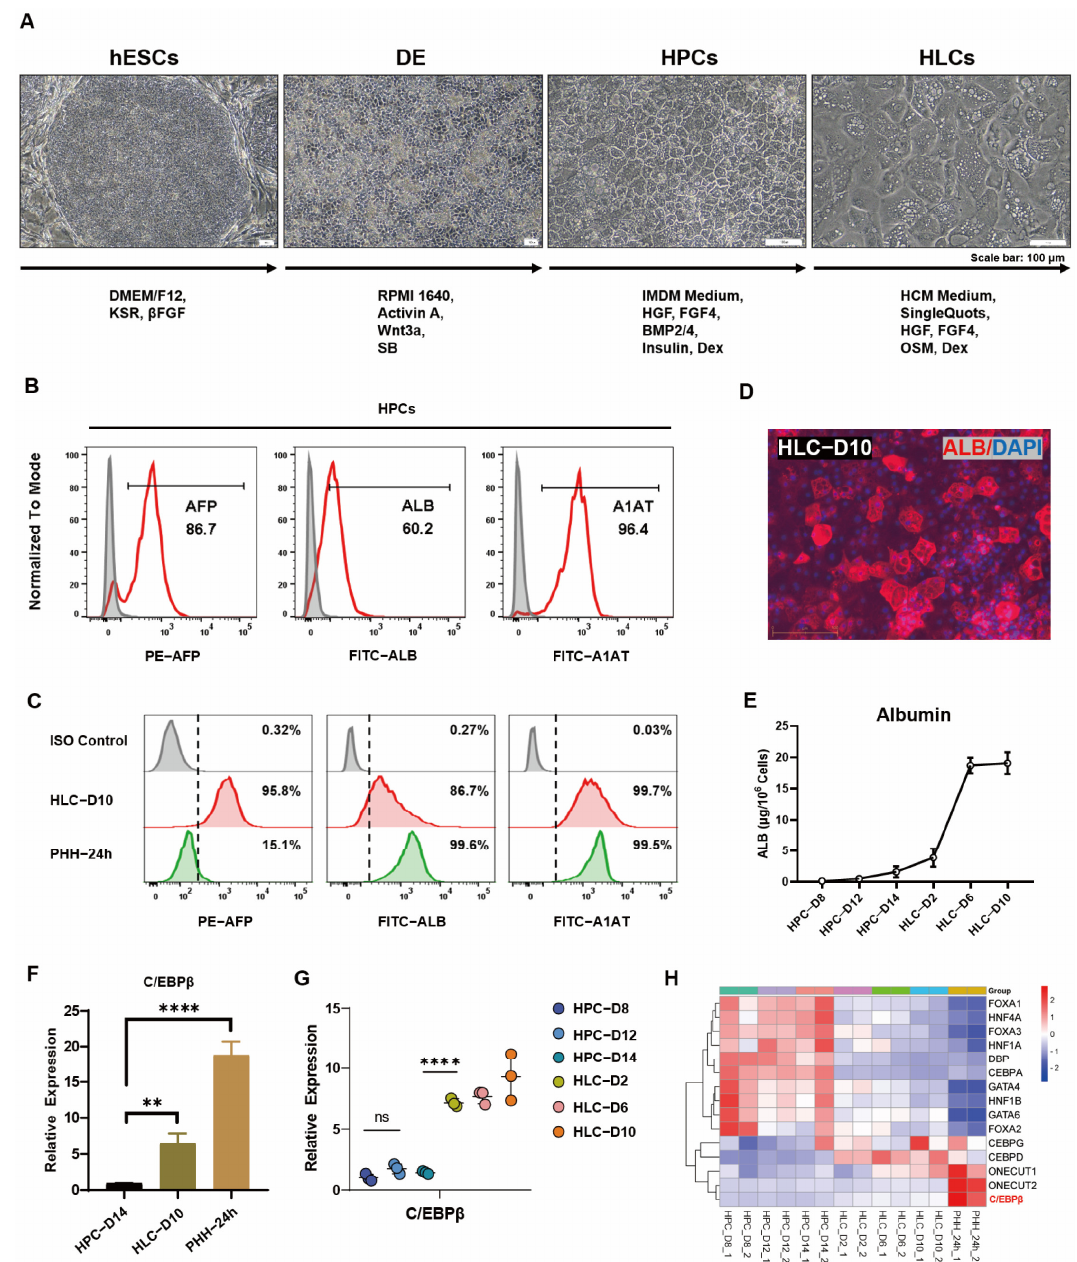
Figure 1. C/EBPβ was enriched in liver and correlated with hepatocyte differentiation. ( A ) Schematic Figure 1. C/EBP β was enriched in liver and correlated with hepatocyte differentiation. ( A ) diagram of the stepwise induction of hESCs into hepatocyte-like cells (HLCs), with representative images showing the morphology of the cells at sequential stages of hESCs, DE cells, HPCs, and HLCs, respectively. Scale bar, 100 µm. ( B ) Flow cytometry analysis for the expression of specific markers at stage of HPC-D14 (AFP, ALB, A1AT). ( C ) Flow cytometry analysis for the expression of